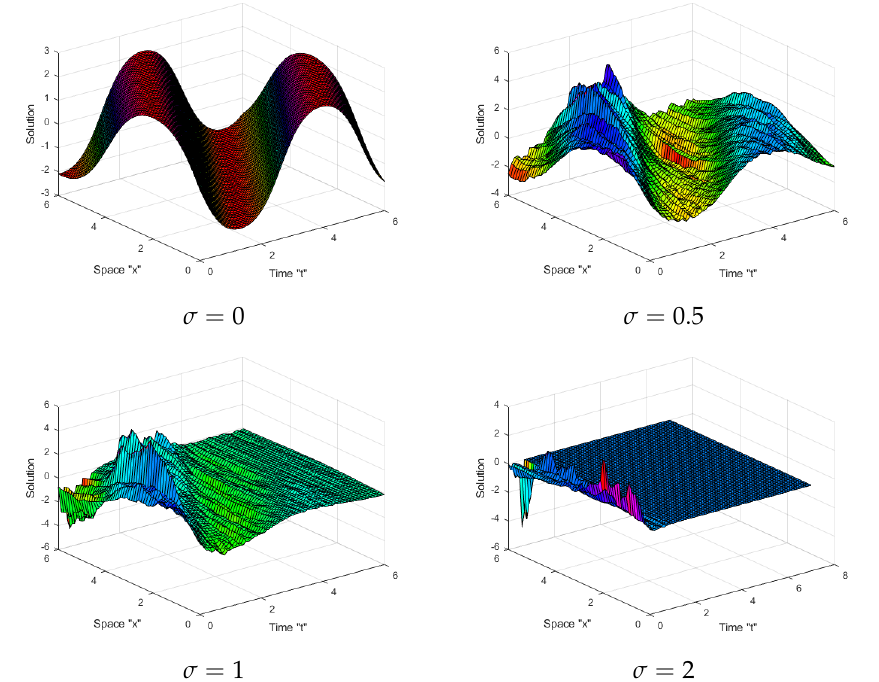
Figure 4. The 3D-profiles of solution Φ ( x , t ) in Equation (16).